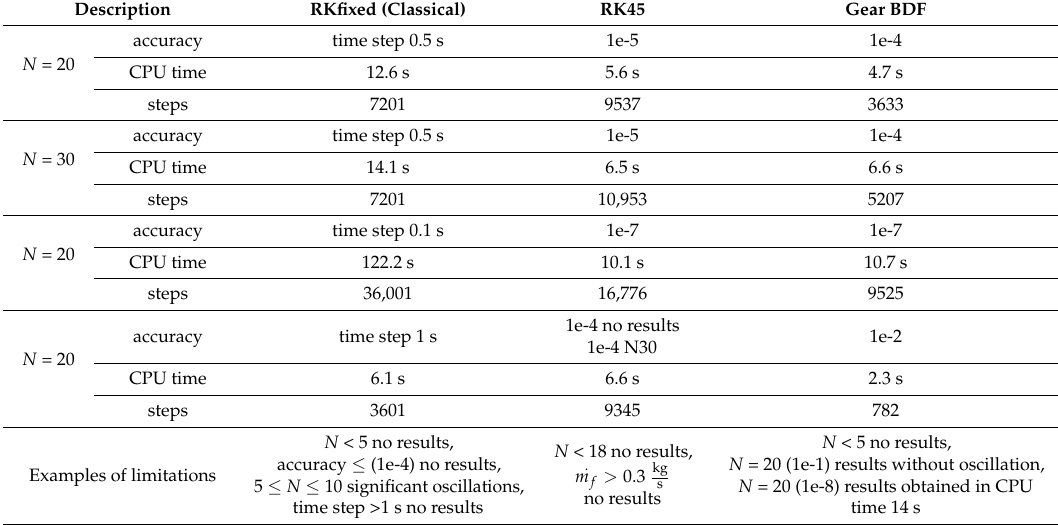
Table 3. Comparison of discretization, accuracy, process time, and numbers of steps for the following numerical methods: RKfixed, RK45, and Gear BDF (Processor Intel, Xeon (R) X5690, 3.46 GHz, 8 GB RAM, 64-bits System).